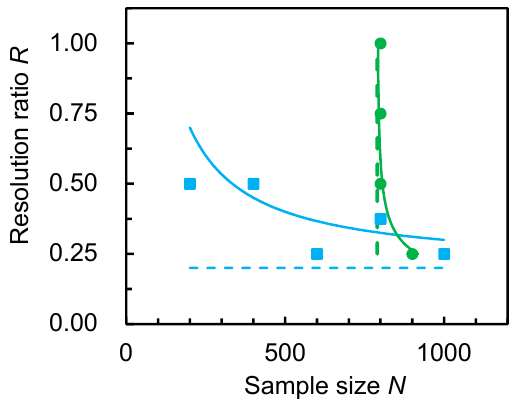
Figure 12. Joint effect of resolution and sample size. Blue squares represents COR at varying sample sizes and green dots represents DREV at varying resolutions.